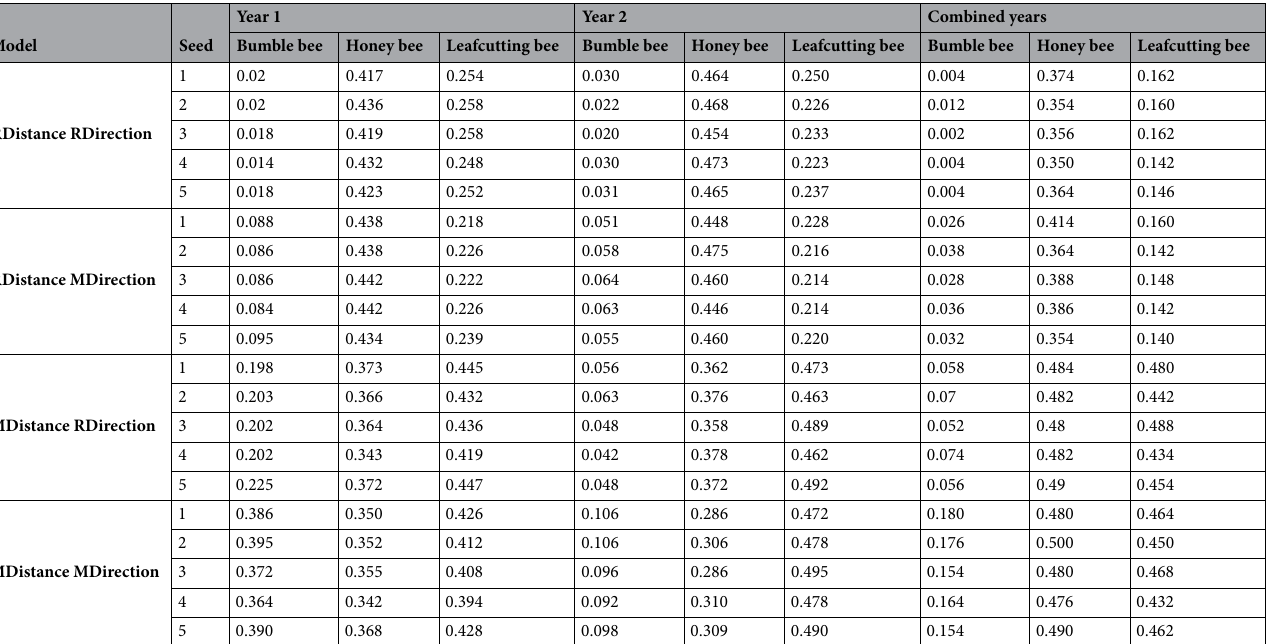
Table 6. Testing the four models of bee movement for each bee species each year and for both years combined (see Table 1 and text for details). The one tailed probability values (p) are presented for the randomization tests. A low probability indicates that the model is not a good fit to the data. The different seeds represent different starting points and test the robustness of the different